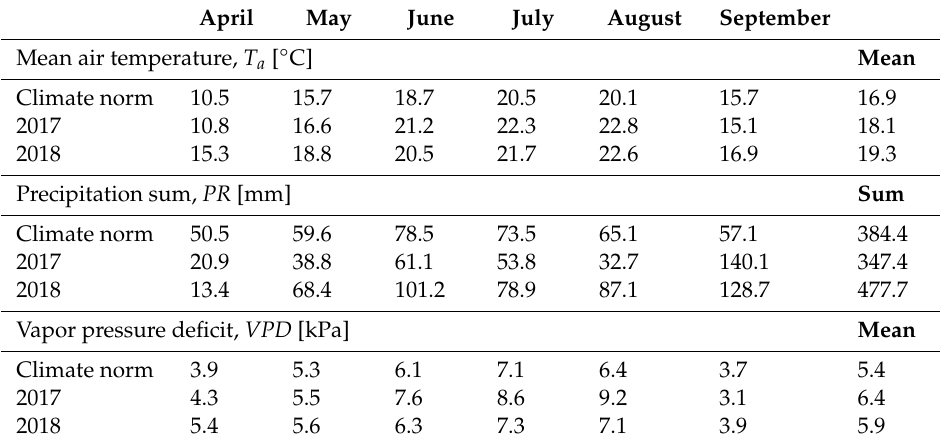
Table 1. Meteorological variables, monthly mean air temperatures ( T a ), rainfall sums ( PR ) and vapor pressure deficits ( VPD ), measured at Keszthely Agrometeorological Research Station during the 2017 and 2018 growing seasons. The climate norms represent the time period between 1971 and